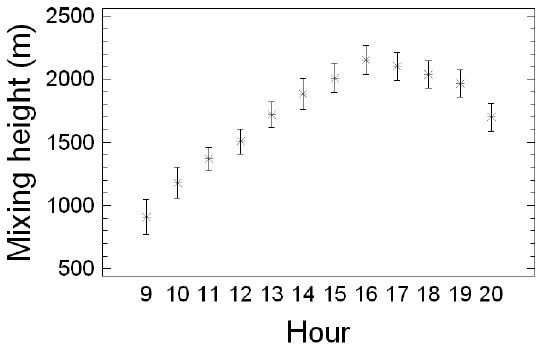
Fig. 4. Correlation coefficients for the linear regression between mixing heights from the profiler measurements and those from the model at specific hours of the day. Black circles correspond to a p- value below 0.01 indicating the statistically significant relationship at a 99% confidence level. White squares correspond to a p-value greater or equal to 0.01 at a 90% or higher confidence